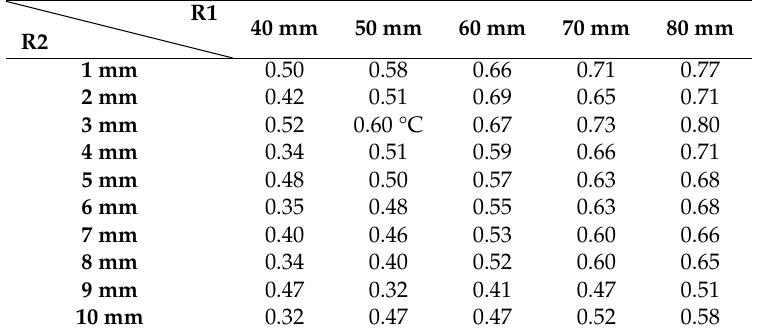
Table 1. Theoretical data for breast cancer analysis at various positions (X = 10, Y = 0).